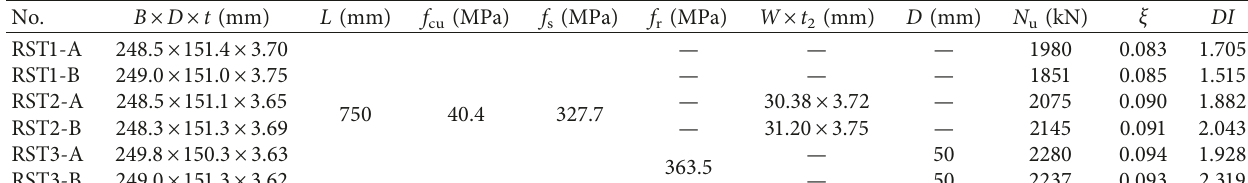
Table 1: Characteristics and geometric properties of CFT